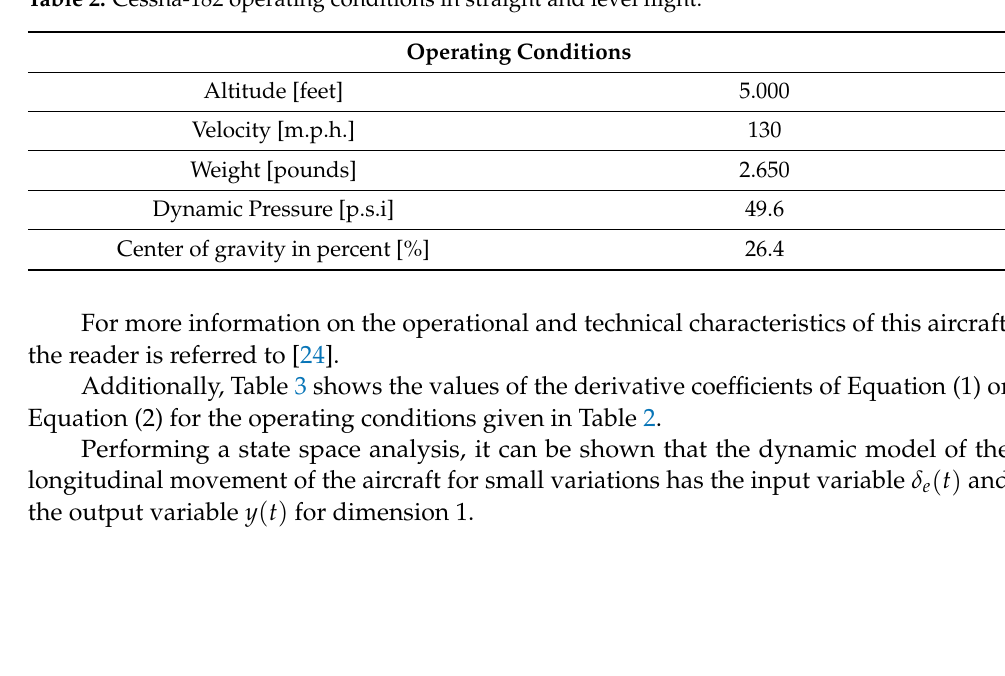
Table 2. Cessna-182 operating conditions in straight and level